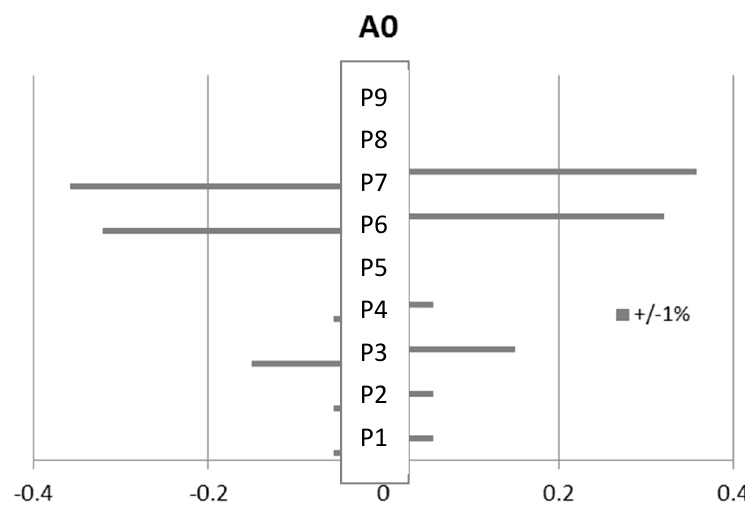
Figure 7. Sensitivity analysis of Alternative 0.